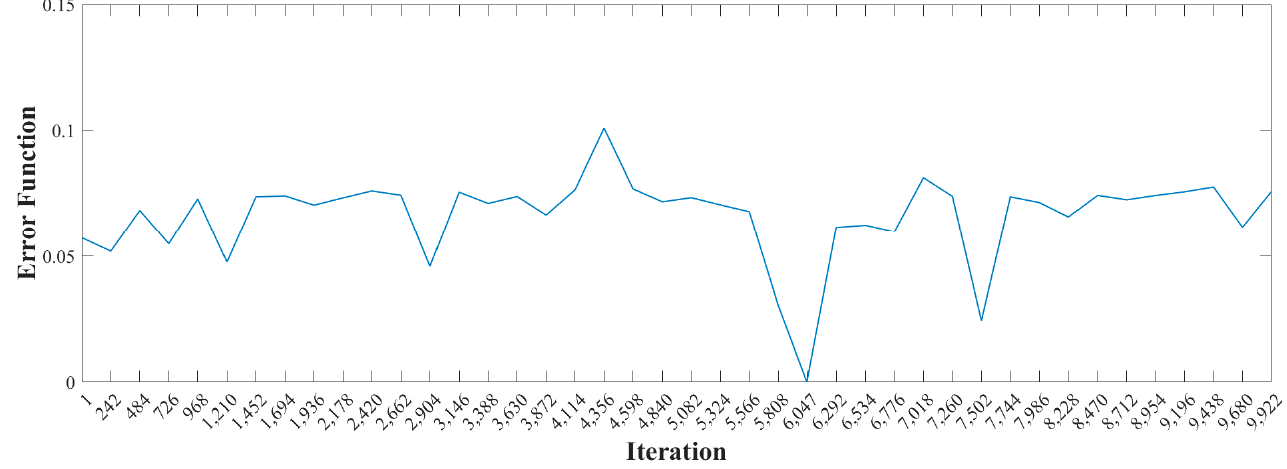
Table 11. Values of k x , k z 1 , and k z 2 that minimize the error function.